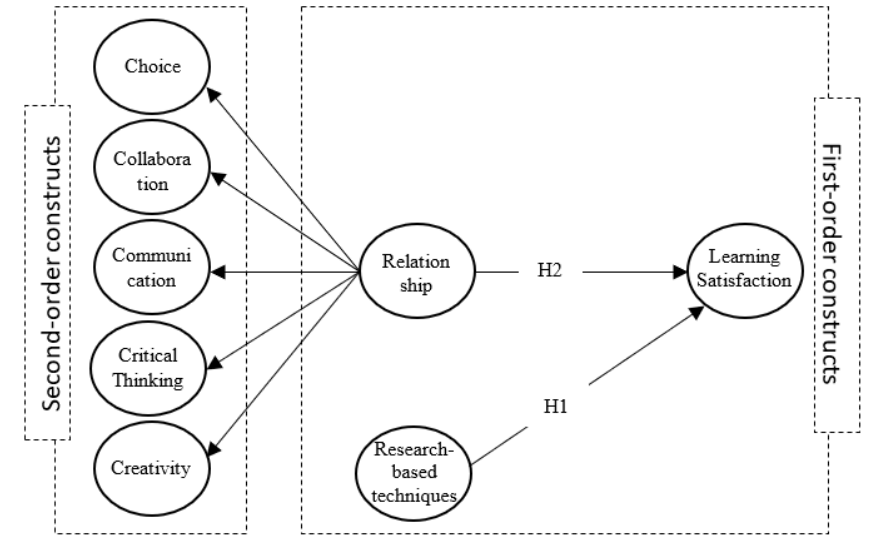
Figure 1. Conceptual Framework